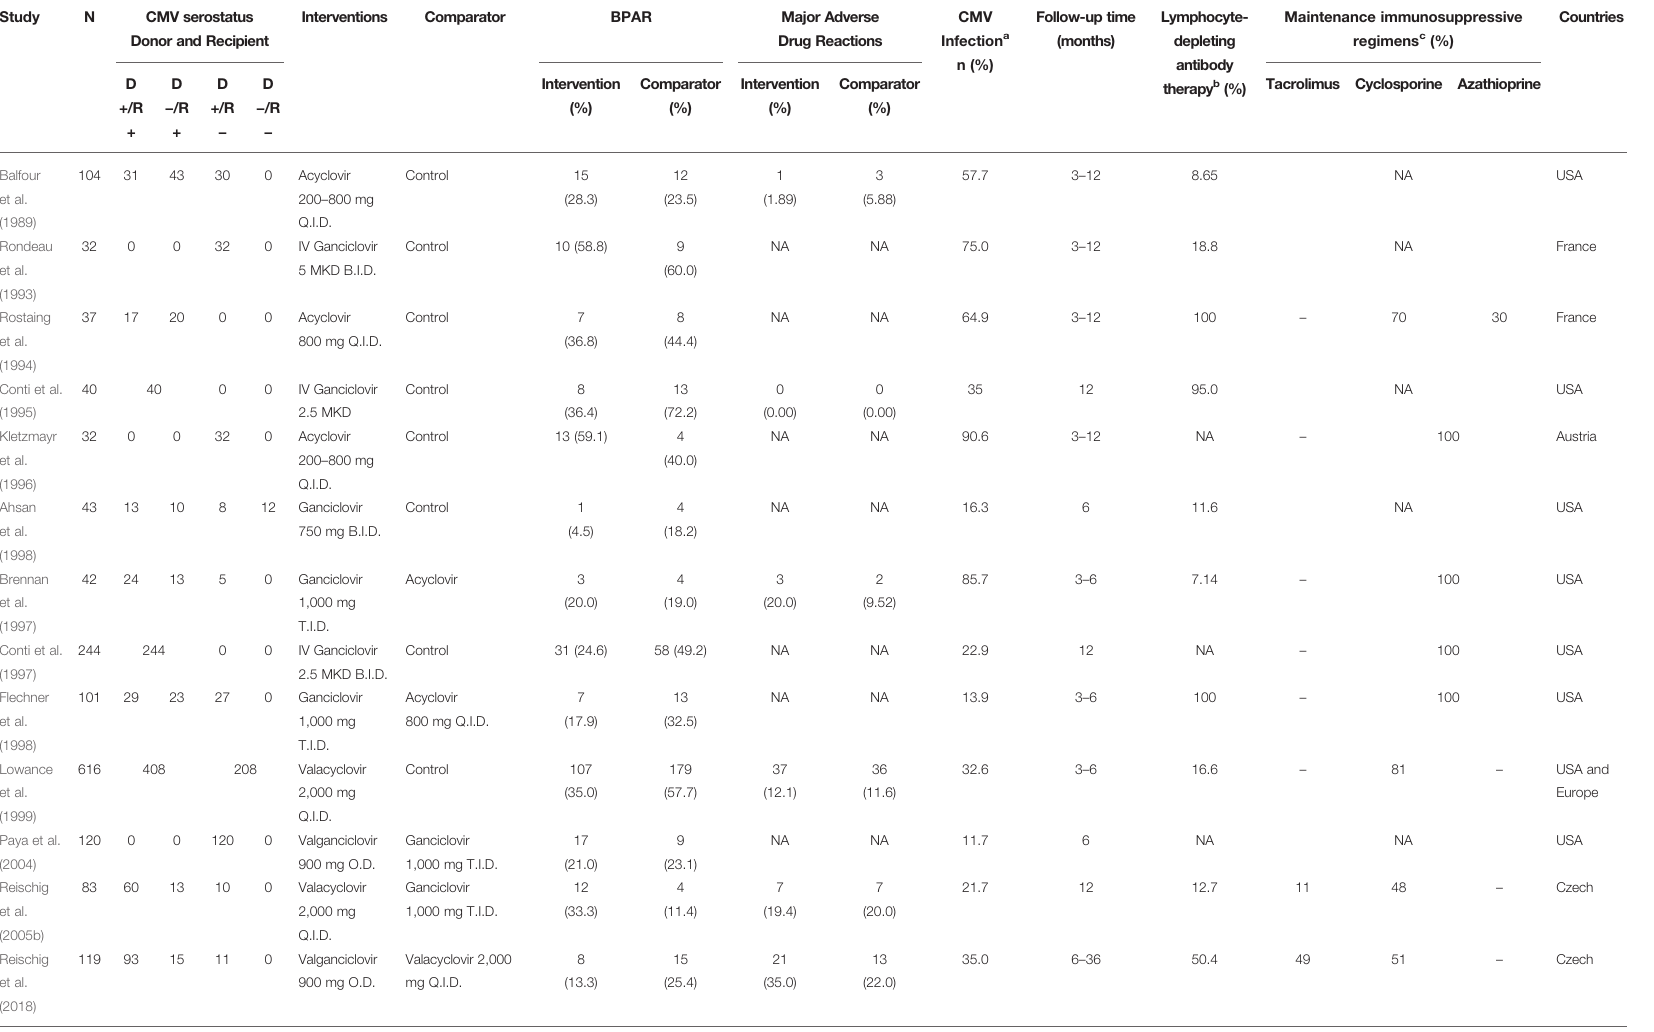
TABLE 1 | Characteristics of studies included in the review and network meta-analysis. Study